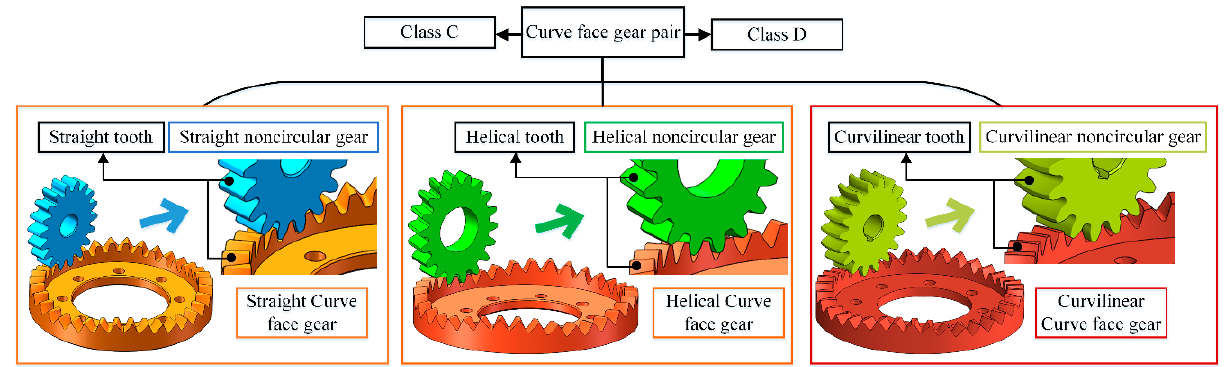
Figure 9. Tooth profile classification of curve face gear pair.